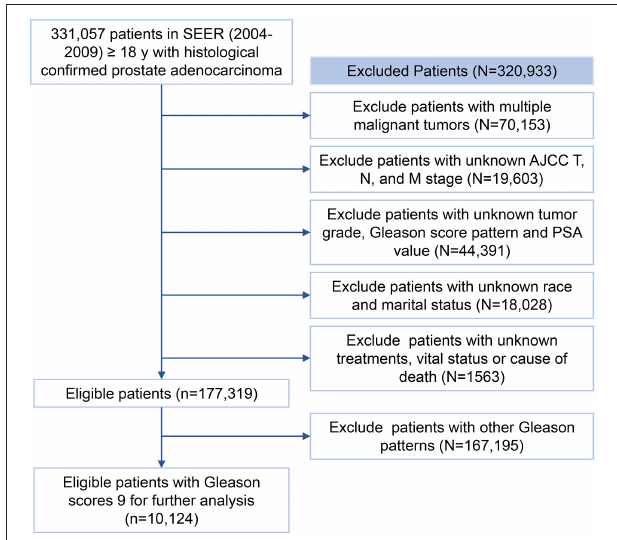
FIGURE 1 | The flow chart of study participants selection. PSA, prostate-specific